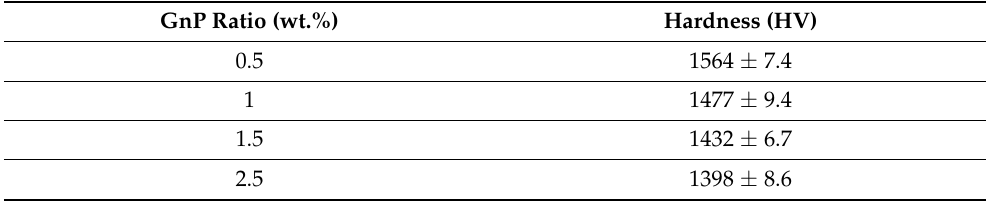
Table 2. The Vickers hardness of the produced nanocomposite samples. GnP Ratio